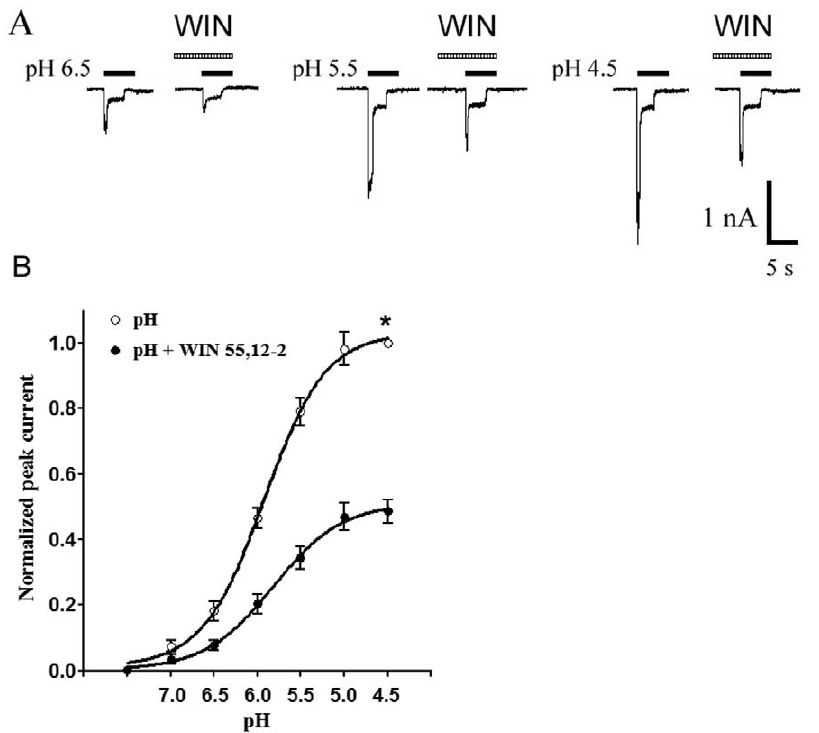
Figure 4. Concentration-response relationship for proton with or without the pre-application of WIN55,212-2. A. Sequential currents evoked by different pH in the absence of WIN55,212-2 (WIN) and presence of WIN. B. The concentration-response curves for proton with or without WIN55,212-2 (10 2 7 M) pre-application. The concentration-response curve for proton with WIN55,212-2 pretreatment shifted downwards. Each point represents the mean 6 SEM of 7–11 neurons. All current values were normalized to the current response induced by pH 4.5 applied alone (marked with asterisk).